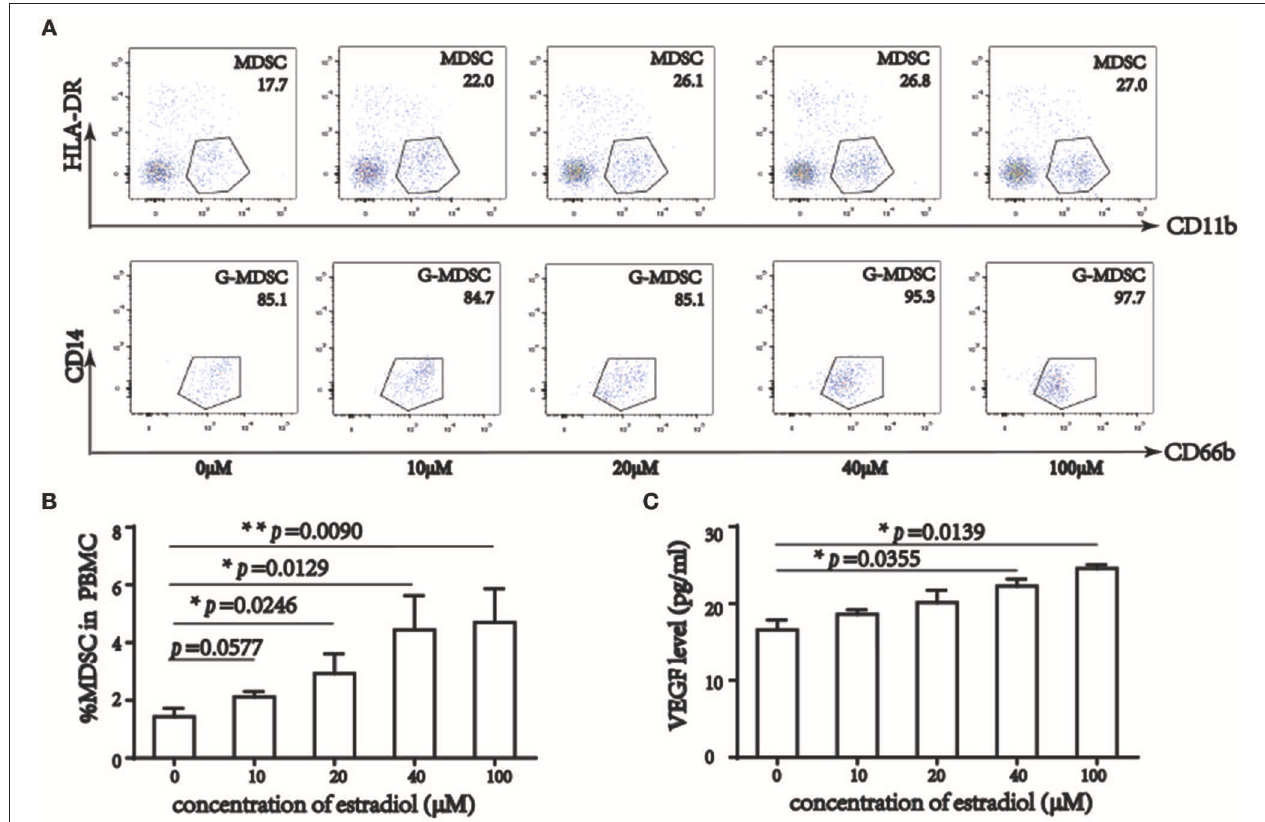
FIGURE 3 | 17 β -estradiol induced MDSC augment and elevated VEGF level in vitro . (A) Flow cytometry analysis showed that percentage of MDSC in PBMC without lymphocyte, 17 β -estradiol induced MDSC augment in a dose dependent manner. (B) Qualification of MDSC in total PBMC. (C) VEGF level in liquid supernatant under 17 β -estradiol treatment. * p < 0.05, ** p < 0.01, *** p < 0.001.